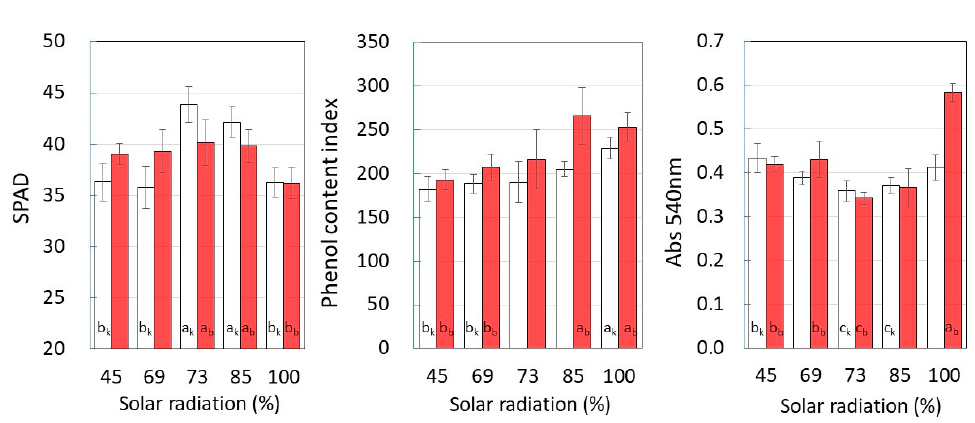
Figure 5. Leaf surface lightness (L*) and yellowness (b*) in each solar radiation, and individual leaf weight. □ ; Suikenkintoki , ■ ; Beniharuka . Data are the means and error bars represent standard error of the mean. Different letters indicate statistically significant differences between cultivation layers ( p < 0.05). Comparing the results in Figures 4 and 5, it can be seen that SPAD and L* and b* including the inside of the multilayer shelves showed the opposite trend, with leaves with high chlorophyll content having a lower amount of reflected light due to increased light absorption. In contrast, leaf size and SPAD showed the same trend, indicating that leaves